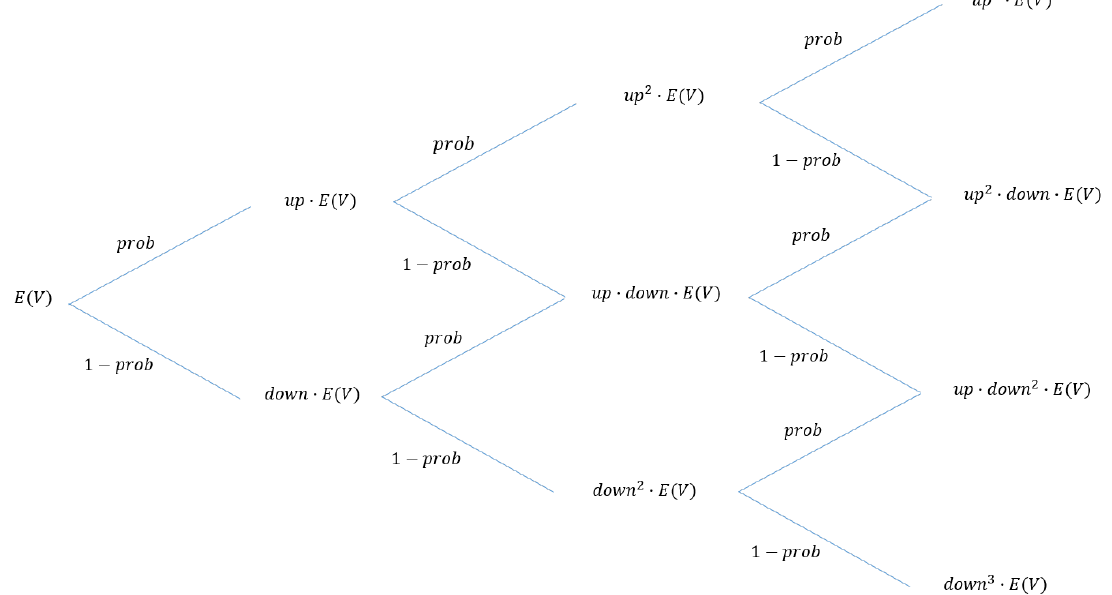
Figure 6. Binomial lattice of the project